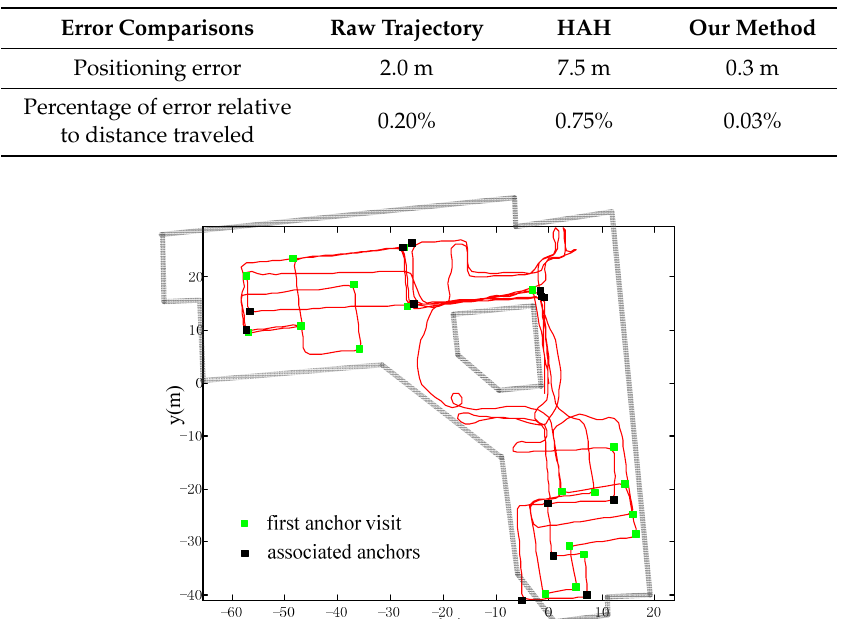
Figure 15. Trajectories for our method, the HAH method and raw trajectory. Our method has better accuracy than HAH and raw trajectory. Table 2. The positioning errors for raw trajectory, HAH method and our method.